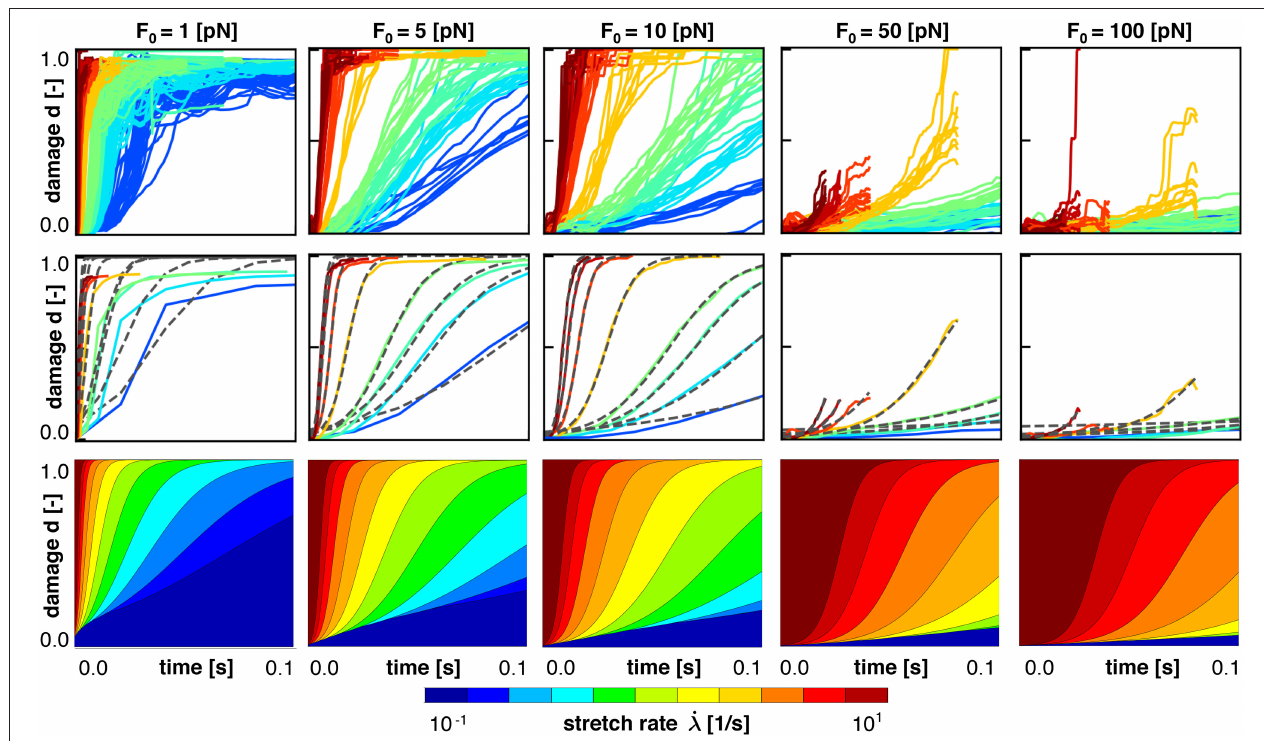
FIGURE 7 | Axonal damage vs. time color coded by the stretch rate for five bond strengths. Discrete axonal damage simulations with n = 10 simulations for each stretch rate (Top) ; homogenization using the average response for each stretch rate to identify the parameters for S-shaped curve of the homogenized damage model (Middle) ; and continuum axonal damage simulation (Bottom) . The graphs represent the same data as in Figure 6 , and demonstrate an important feature of the Bell model: at higher stretch rates, axonal damage occurs at higher axonal stretch, but earlier in time.